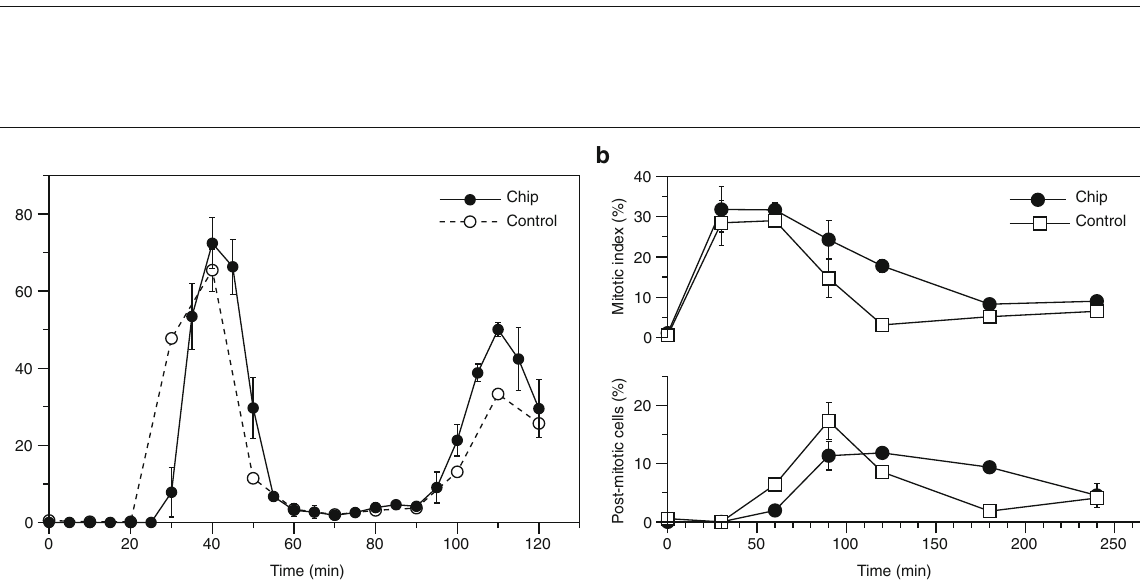
Fig. 5 Absorption of small molecules by the elastomer. All experiments were performed using chips as described in Additional file 4C. a. The absorption of small molecules by the elastomer restricts the area of the chip that can be monitored when treating cells with such molecules. Fission yeast cells operating with a modified cyclin-dependent kinase (CDK) module that is sensitive to inhibition by the 3-MBPP1 ATP analogue [37] were injected in a lectin-coated microsystem and exposed to a 20 μ L/min flow of medium containing 1 or 0.4 μ M 3-MBPP1, with sample temperature maintained at 32 °C. After 3 h, septation indexes were determined at different distances from the border of the channel. Graphs represent the averages of 3 independent experiments ( n > 50 for each experiment) with standard errors. Note that to facilitate this proof-of- concept assay, the sample temperature was maintained using a high precision hot plate. b. DIC images of cells in a at the border and at distances of 0.5 and 1 mm from the border of the chip. At ≥ 1 mm from the border of the chip, both concentrations of inhibitor led to a complete G2 arrest, as seen in the control experiments (cells exposed to 3-MBPP1 in standard batch cultures). The size at division of cells at the border when treated with 1 μ M 3-MBPP1 was 23.2 μ m (average of 3 independent experiments, standard error: 0.7; n > 40 for each experiment), which is significantly larger than in inhibitor-free medium (compare with Fig. 4a). This demonstrates that not all of the inhibitor is absorbed by the elastomer. Scale bars = 10 μ m